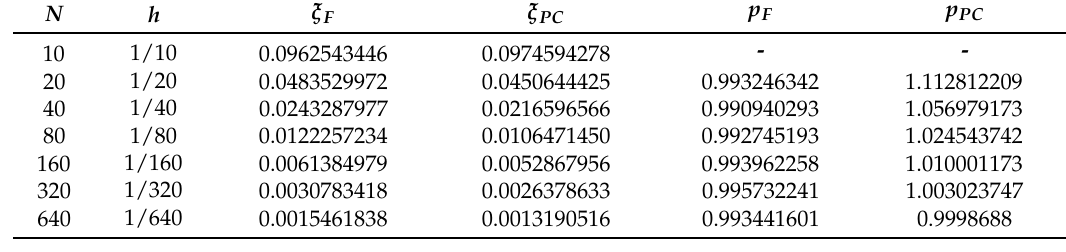
Table 4. Error analysis of numerical methods for Example 2 ( β = 2).